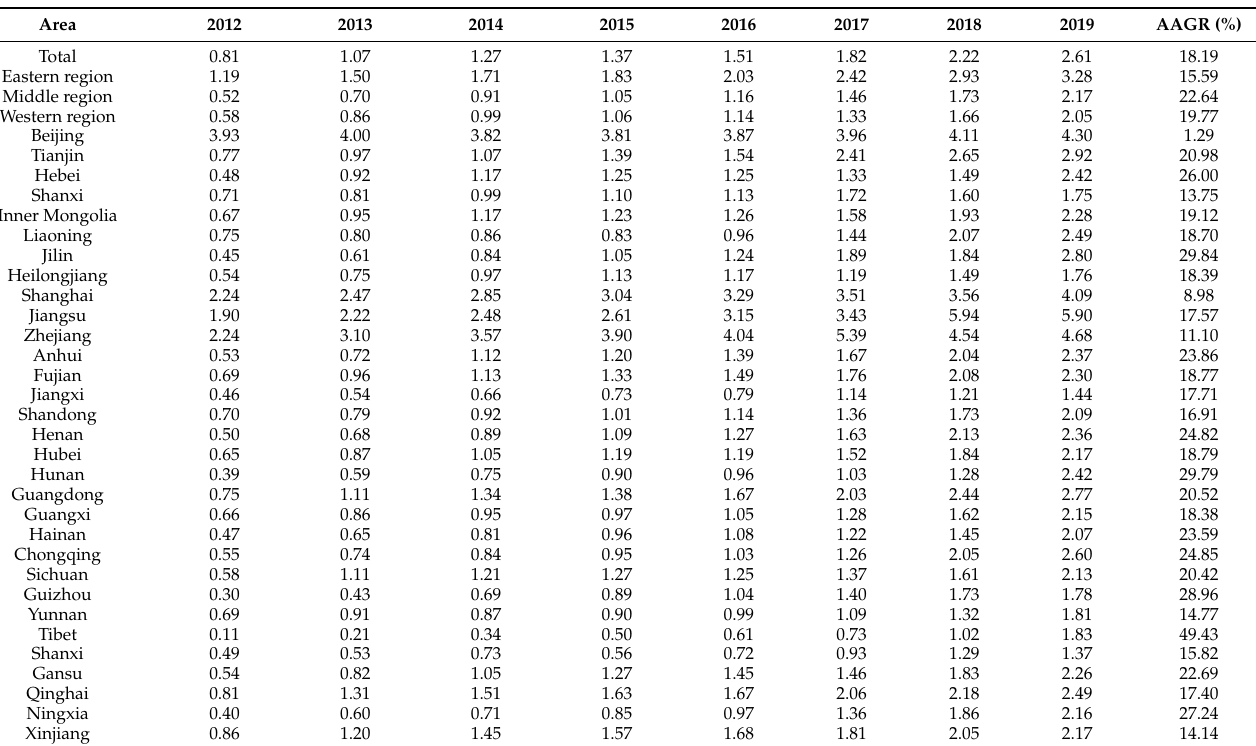
Table 2. Number of GPs per 10,000 in 2012–2019 in China.